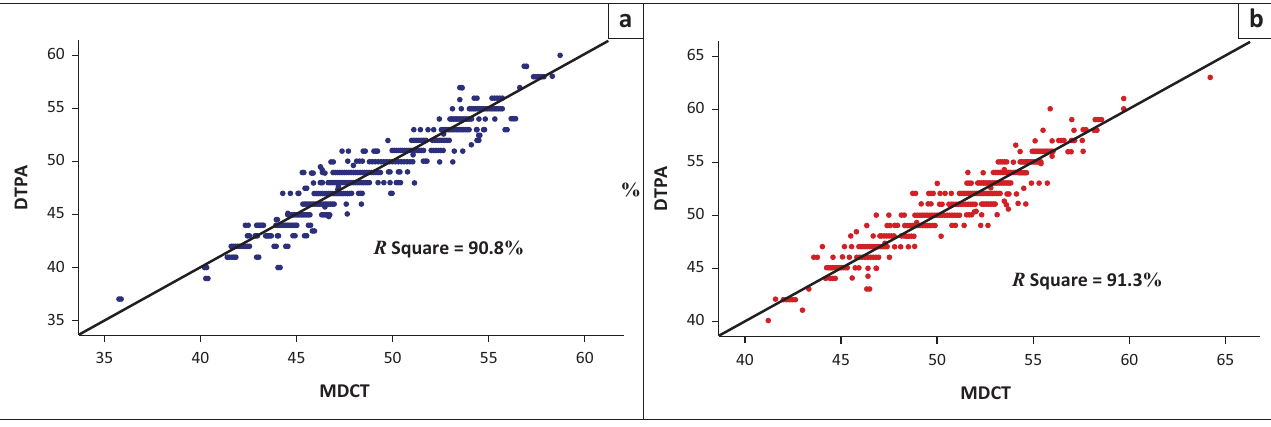
FIGURE 4 : An error bar graph depicting the comparison of split renal function between diethylenetriaminepentaacetic acid and multidetector computed tomography for male and female in (a) the left kidney and (b) the right kidney.